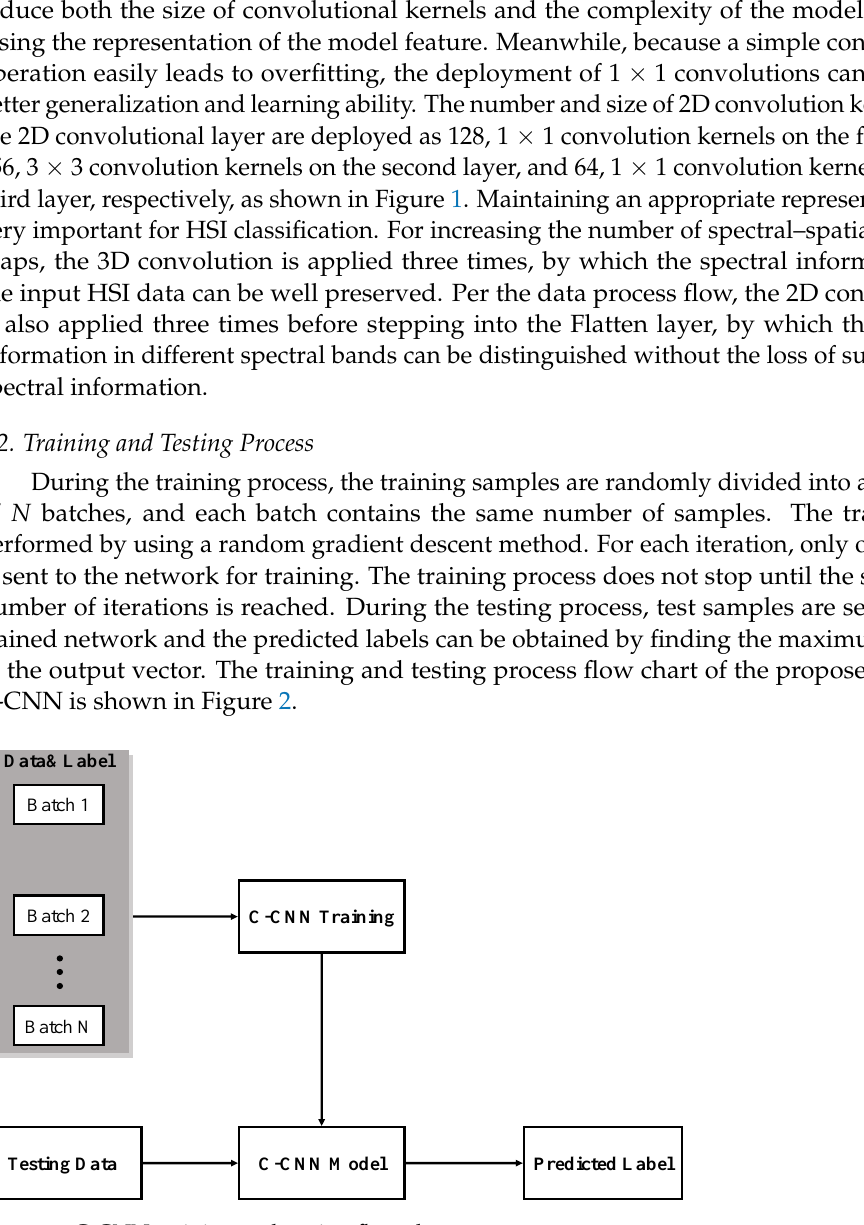
Figure 2. C-CNN training and testing flow